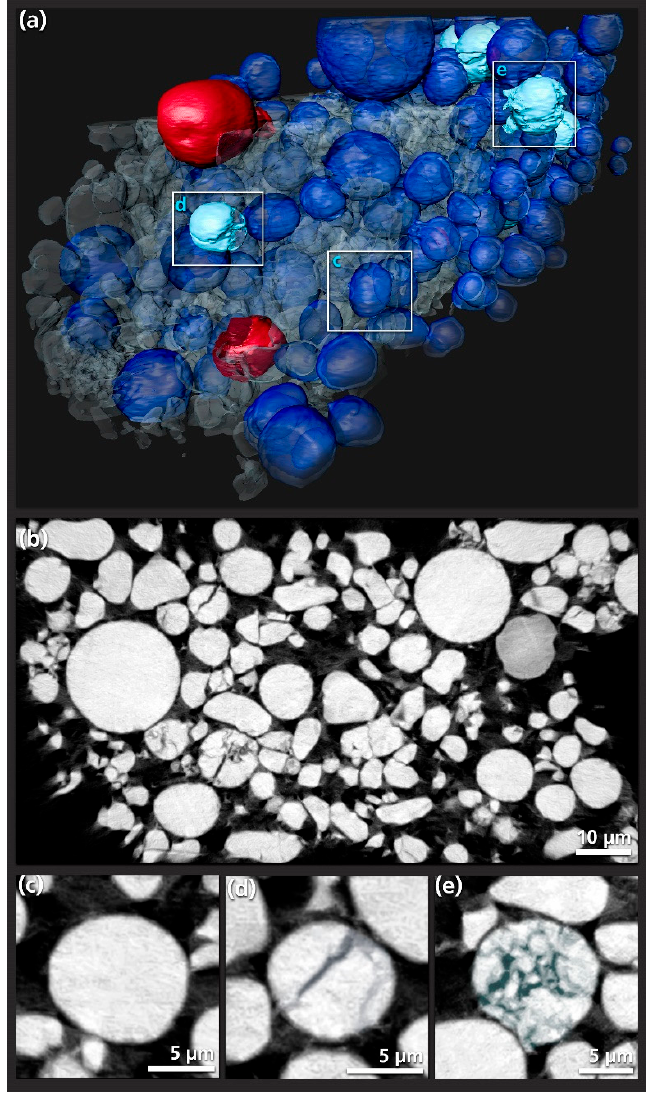
Figure 8. Reconstruction of the high-resolution nano CT measurement of the electrode of a commer- cial lithium pouch-cell with 105 nm sampling. ( a ) 3D rendering of the sample. Typical spherical particles in the electrode are shown in blue, spherical particles with an already strong fragmentation inside are turquoise, the two red particles have a much weaker absorption and seem to have a differ- ent material composition. ( b ) unrendered sectional image from the reconstructed volume to obtain an overview of the aging state. ( c – e ) enlarged sections of individual spherical particles. ( c ) in good condition as the majority of the sample. ( d ) medium fissure as the first consequence of mechanical or chemomechanical stress. ( e ) already heavily broken